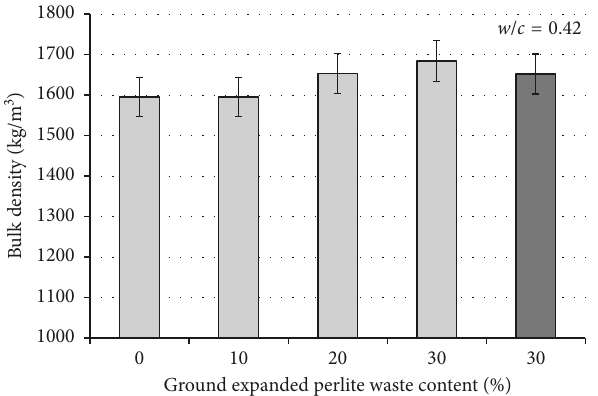
Figure 6: Thermal conductivity of pastes with ground expanded perlite waste addition.